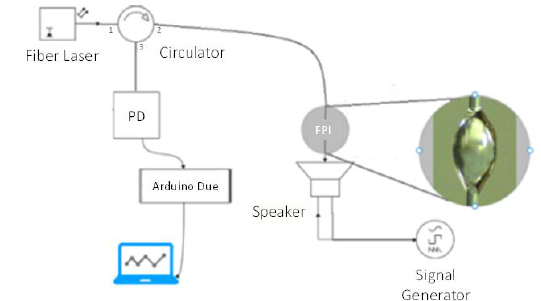
Fig. 3. Schematic of the operation principle. It is composed of a detection system on the left and by an FPI sensor attached to the membrane of a speaker on the right. The inset shows the microscope image of the resin based FPI sensor.